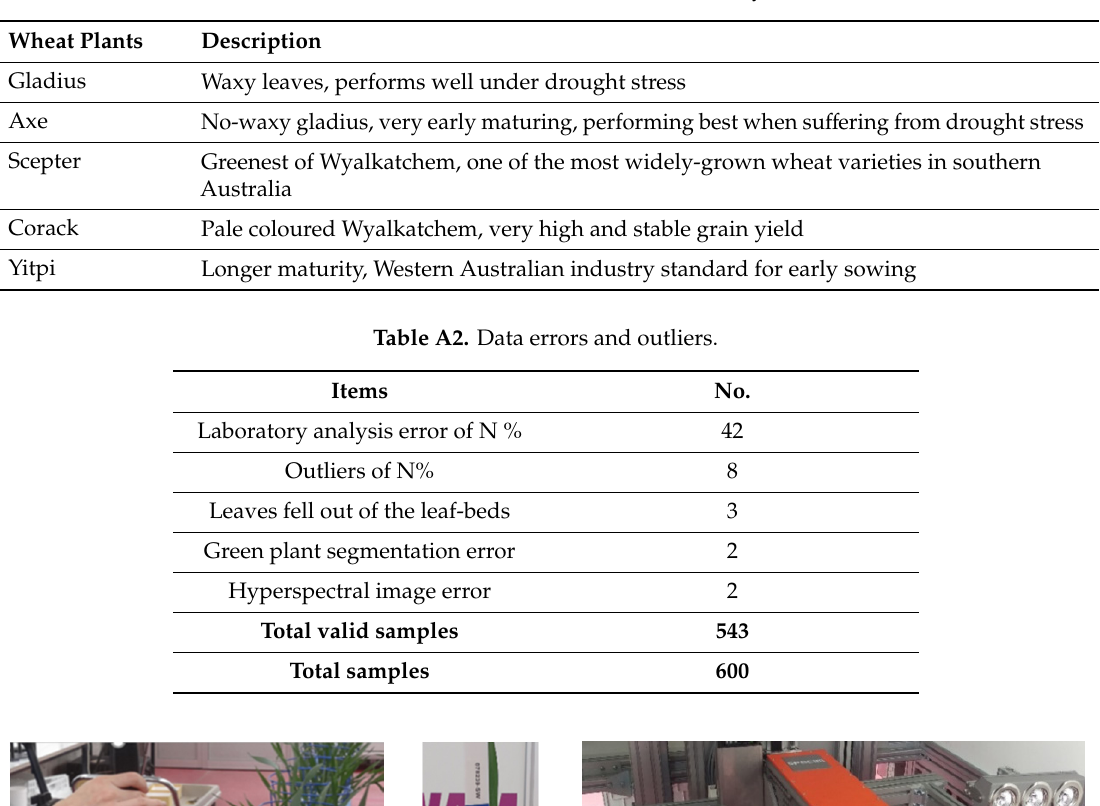
Table A1. Wheat varieties used in this study.